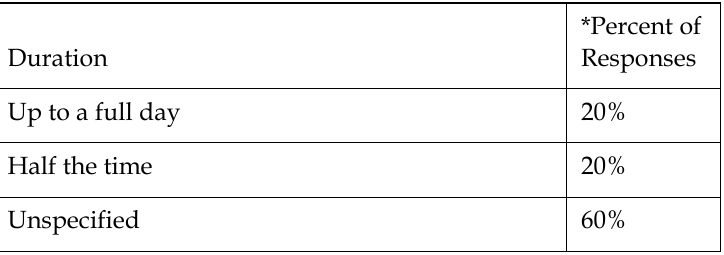
*Percent of Responses